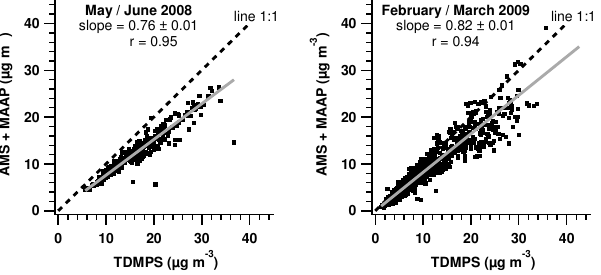
Figure 1. Measured AMS + MAAP mass concentration vs. TDMPS estimated mass concentration for May/June 2008 (left) and February/March 2009 (right) periods. Estimation of the TDMPS mass concentration was made using equation 1. Correlation curves were calculated using the least orthogonal distance fit method.